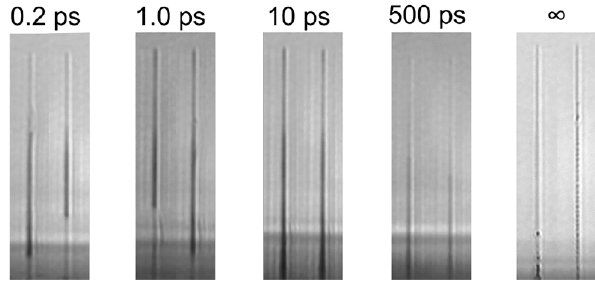
Figure 3: Optical microscopy images of several channels produced using double pulses for a total energy of 5 μ J. Two channels in each image were obtained with the same parameters. The images of each channel have been cropped and stitched together to save fi gure